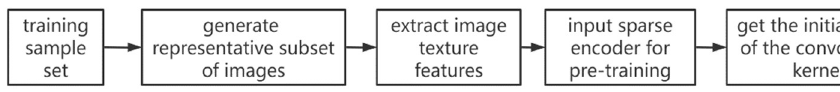
Figure 1. CIFAR-10 data set image sample.